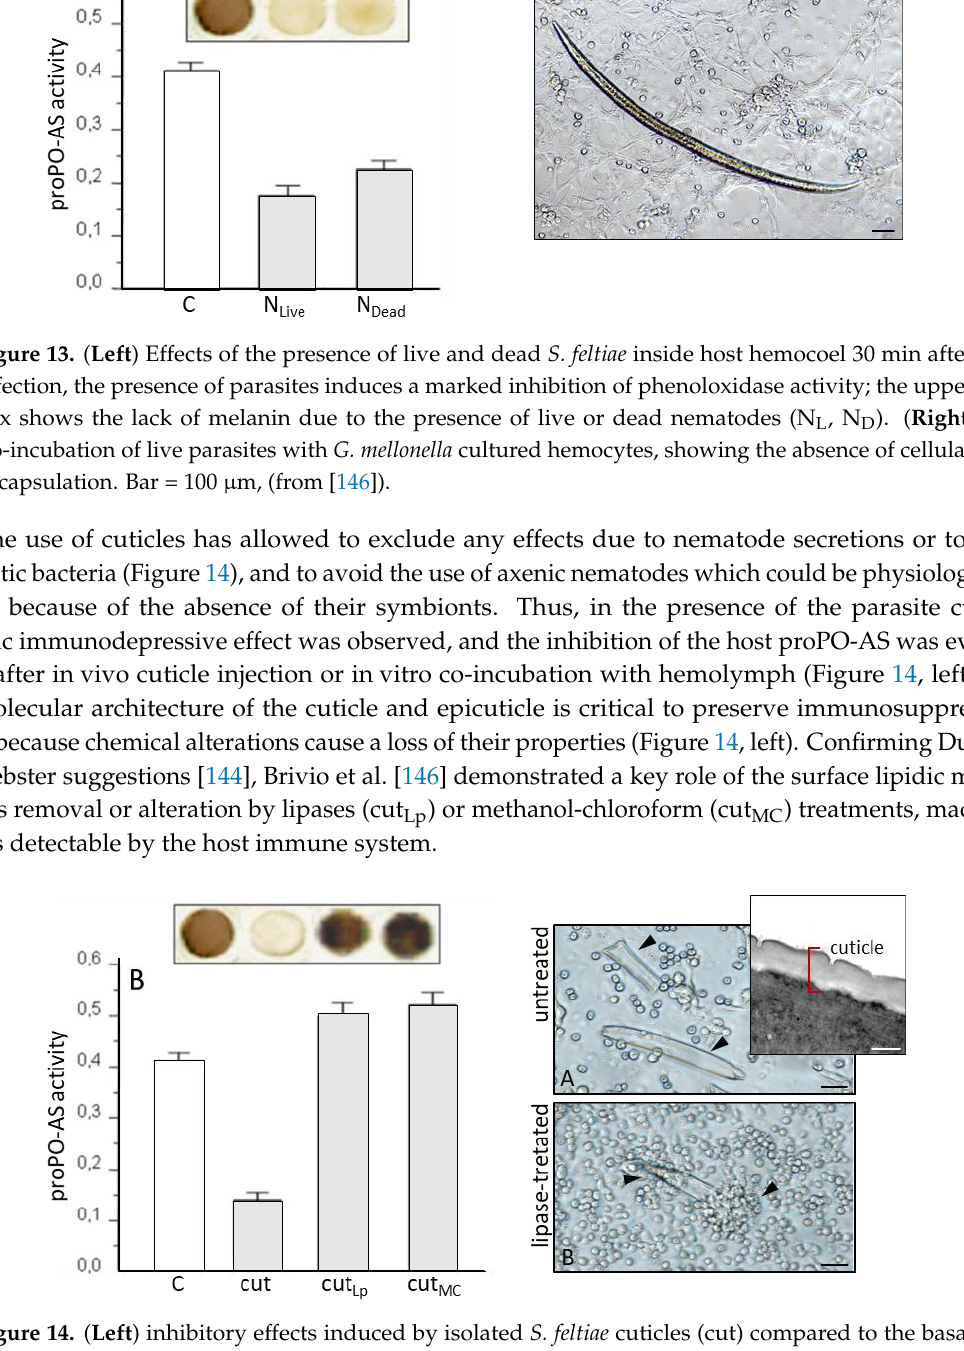
Figure 14. ( Left ) inhibitory effects induced by isolated S. feltiae cuticles (cut) compared to the basal PO activity (C). The damage of cuticle lipids by lipase treatments (cut Lp) or methanol-chloroform extractions (cut MC ) resulted in a marked activation of the host proPO-AS. The upper box shows the lack of melanin synthesis in the insect hemolymph due to the presence of isolated cuticles (cut), melanin was evident when the hemolymph was incubated with treated cuticles (cut Lp and cut MC ). ( Right ) co-incubation of untreated and lipase-treated cuticles with G. mellonella hemocytes; untreated cuticles are not recognized and encapsulated; instead, when they were treated with lipases, migration of hemocytes and encapsulation were observed. Inset: TEM micrograph of the S. feltiae cuticle/epicuticle in peripheral region of body. Black bars = 100 µ m; white bar = 500 nm, (from